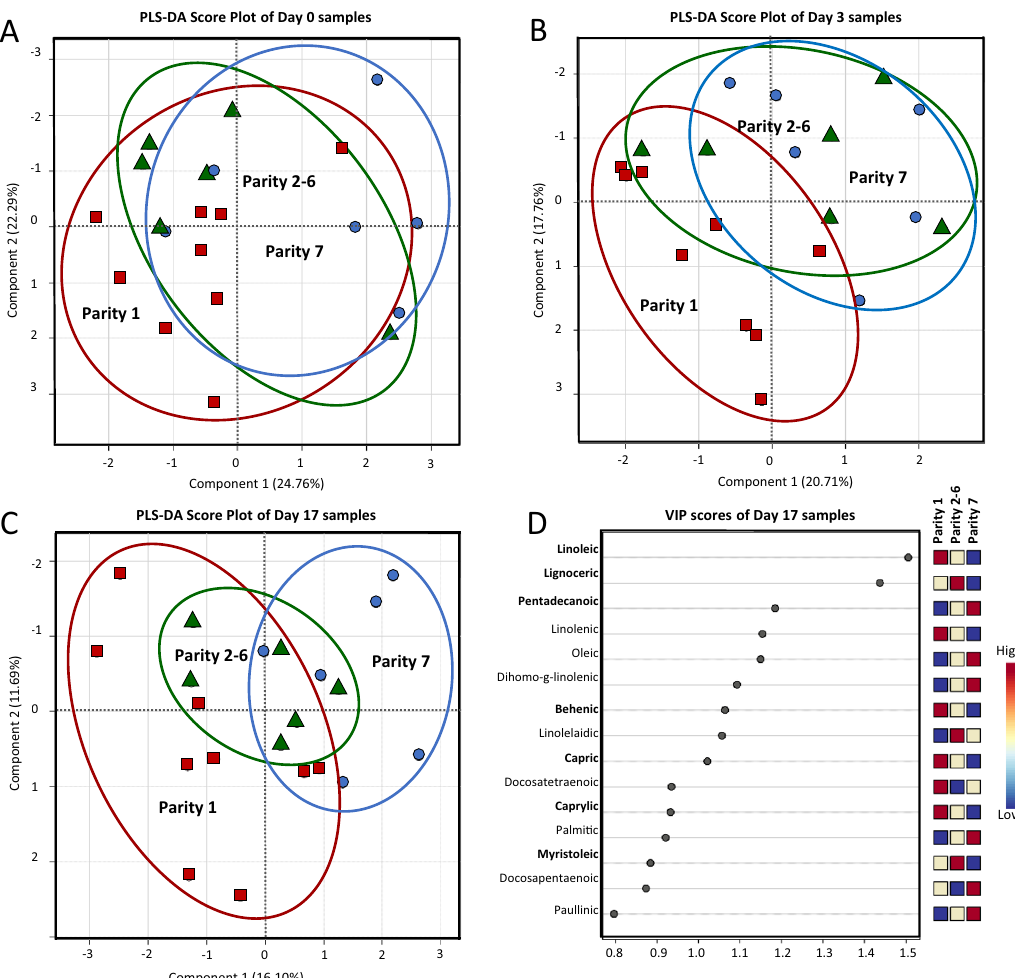
Figure 2. PLS-DA score plots for the comparison of fatty acid profiles of colostrum (day 0; panel A ), transient milk (day 3; panel B ) and mature milk (day 17; panel C ) samples collected from sows in parity 1 ( (cid:31) ), parity 2–6 ( (cid:31) ) and parity 7 ( (cid:31) ). VIP scores derived from the comparison among mature milk samples (day 17) with indicative fatty acids accountable for the discrimination and their relative abundances are visualized in panel